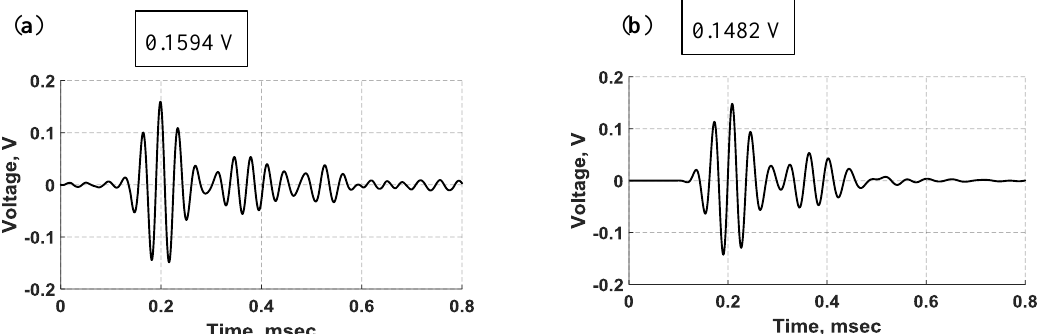
Figure 6. Waveform signals sensed by d35 PZT transducers embedded in the bondline of the laminate structure: ( a ) Experiment; ( b ) simulation.